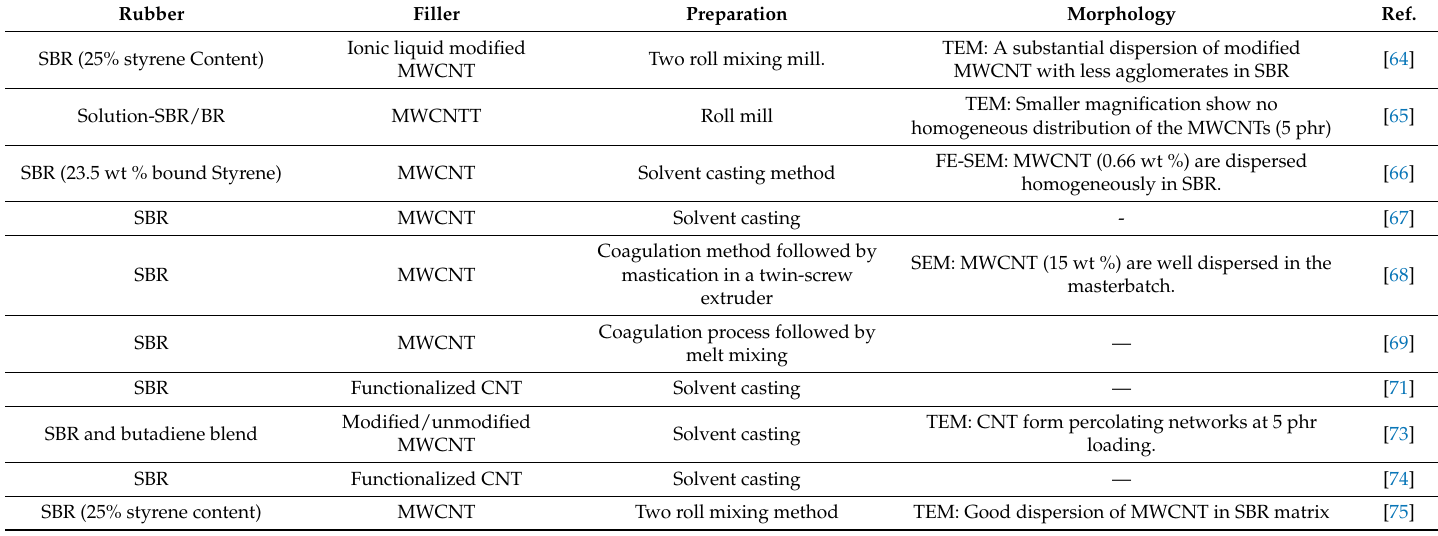
Table 2. Types of carbonaceous nanofillers, preparative methods adopted and morphology of SBR